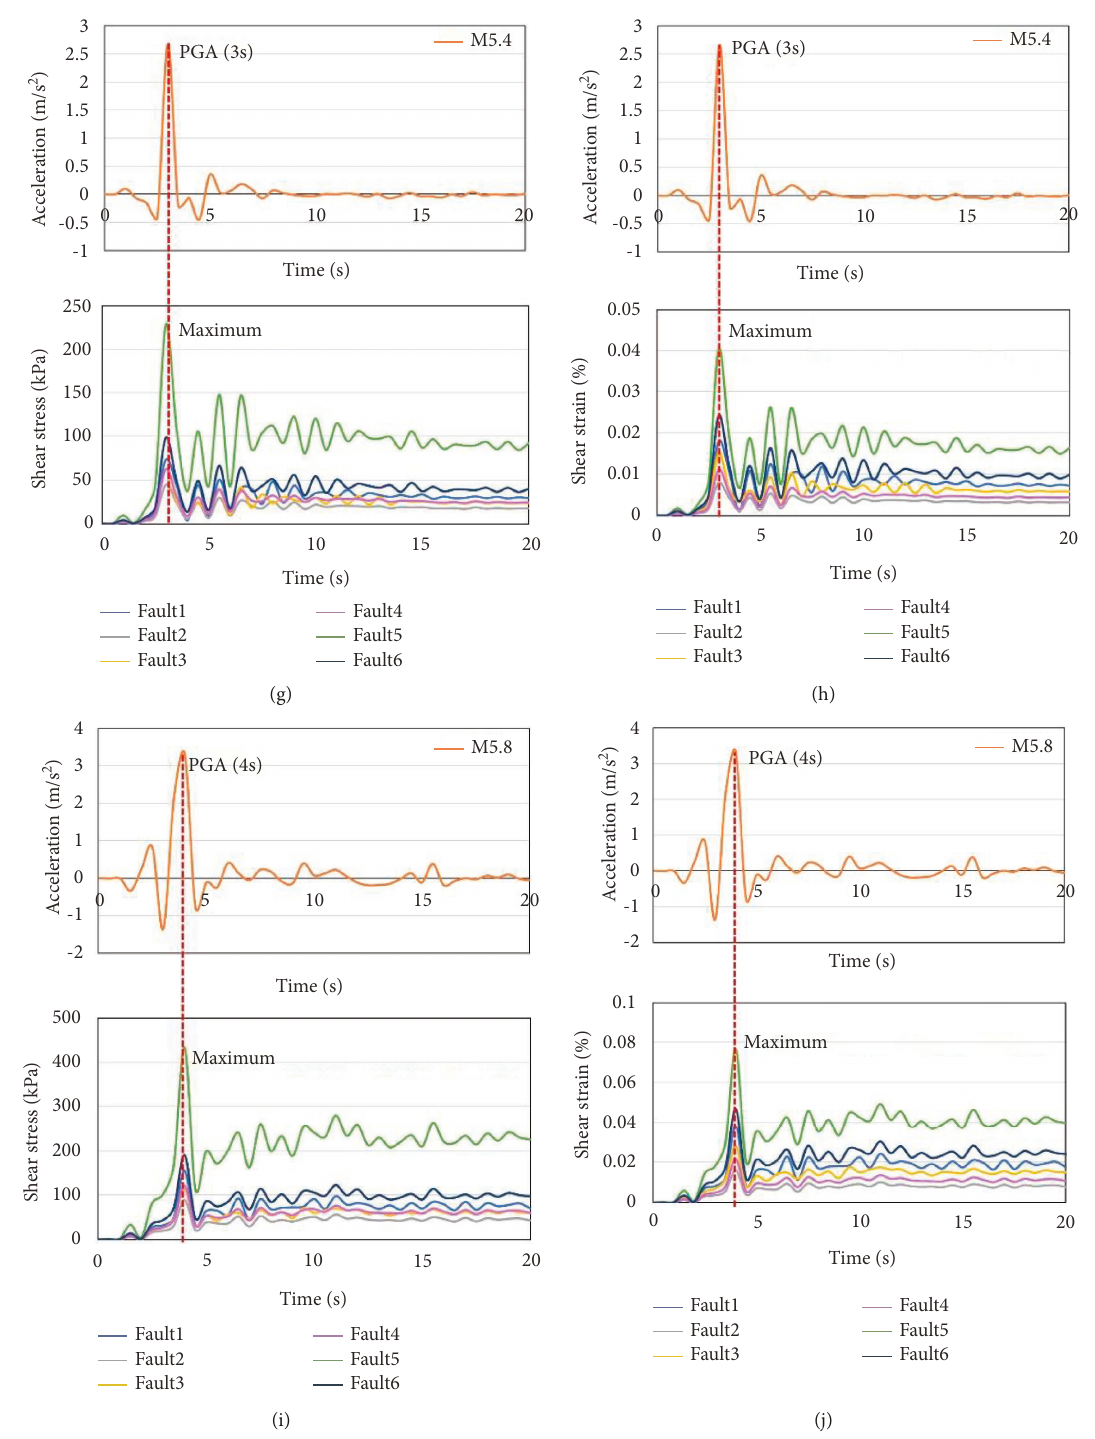
Figure 5: Correlations between the time history, and shear stress and strain for each earthquake. (a) and (b) M3.0, (c) and (d) M3.9, (e) and (f) M5.1, (g) and (h) M5.4, and (i) and (j) M5.8. (a) Shear stress due to the M3.0 earthquake. (b) Shear strain due to the M3.0 earthquake. (c) Shear stress due to the M3.9 earthquake. (d) Shear strain due to the M3.9 earthquake. (e) Shear stress due to the M5.1 earthquake. (f) Shear strain due to the M5.1 earthquake. (g) Shear stress due to the M5.4 earthquake. (h) Shear strain due to the M5.4 earthquake. (i) Shear stress due to the M5.8 earthquake. (j) Shear strain due to the M5.8